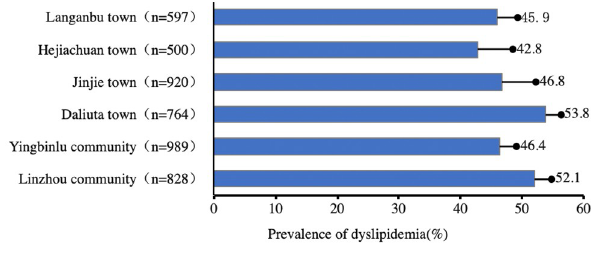
Fig 1. Distribution of sampling points and